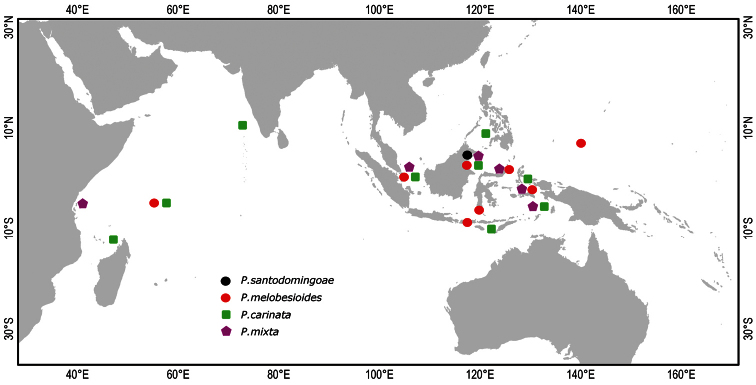
Distribution of Placospongia spp. in the Indo-West Pacific. Location of symbols is approximate.